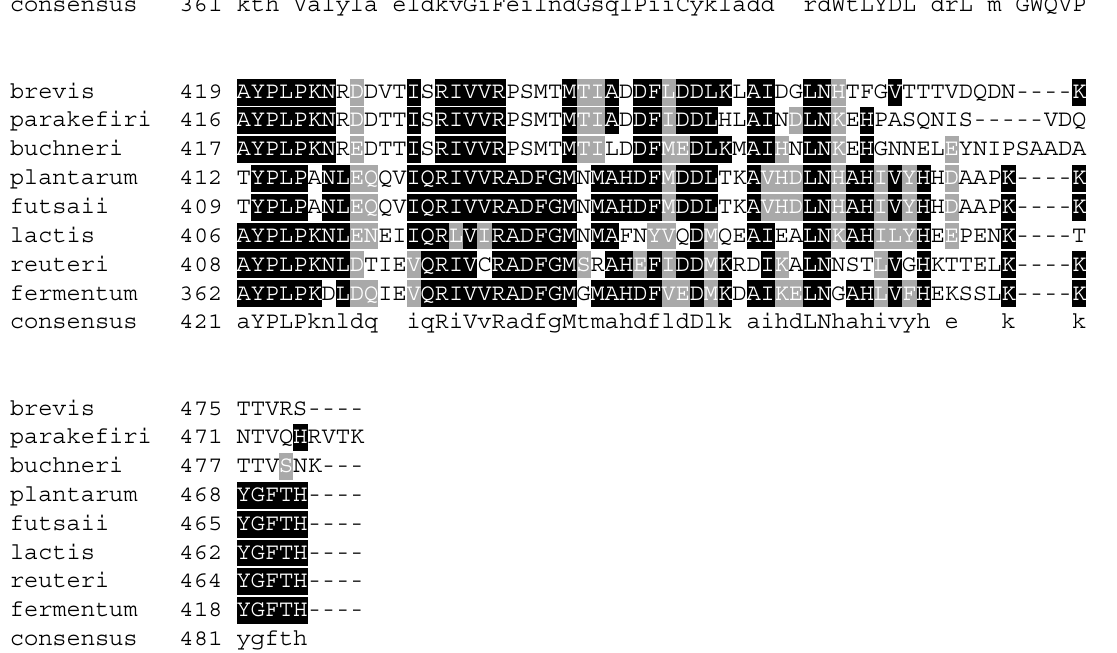
Figure 8. Comparison of amino acid sequences of GAD from L. brevis , L. parakefiri , L. buchneri , L. plantarum , L. futsaii , L. lactis , L. reuteri , and L. fermentum . The accession numbers of these sequences are GAW73186.1, ERK43696.1, KRL34909.1, AEB72391.1, OYT00901.1, ESS01667.1, BBA26472.1, and OSP86418.1, respectively. The alignment of amino acids was generated using the Clustal Omega software. The boxed sequence indicates residues HVD(A / S)A(S / F)GG; this sequence is highly conserved in PLP-dependent decarboxylases [48,55]. Furthermore, the residues SINA / V / TSGHKYGM / LVYPGI / V / LGWI / VV / LW / R / K / V are part of the PLP-binding domain